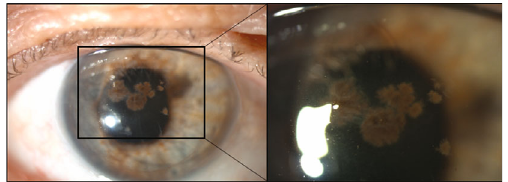
Figure 1: Slit-lamp image of the right eye at presentation. Dark multilobular lesions within deep stroma and a Descemet Stripping Automated Endothelial Keratoplasty graft as a subtle